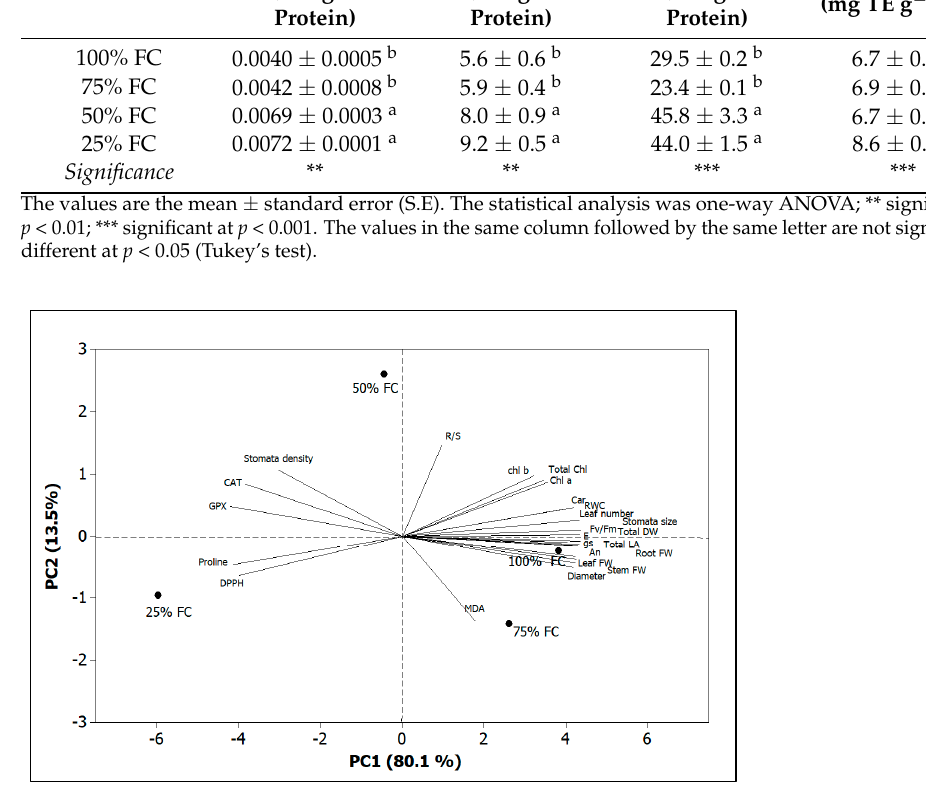
Figure 6. Principal component loading plot and scores of PCA fresh weight and dry biomass, R/S, total leaf area, leaf number, photosynthetic pigments (Chl a and b , total Chl, and carotenoids), stomata characteristics, gas exchange, RWC, Fv/Fm, MDA, proline (Pro), enzyme activity (GPX, CAT. and SOD), and DPPH for zinnia plants with different drought stress treatments (100% FC, 75% FC, 50% FC, and 25% FC) according to the first two principal